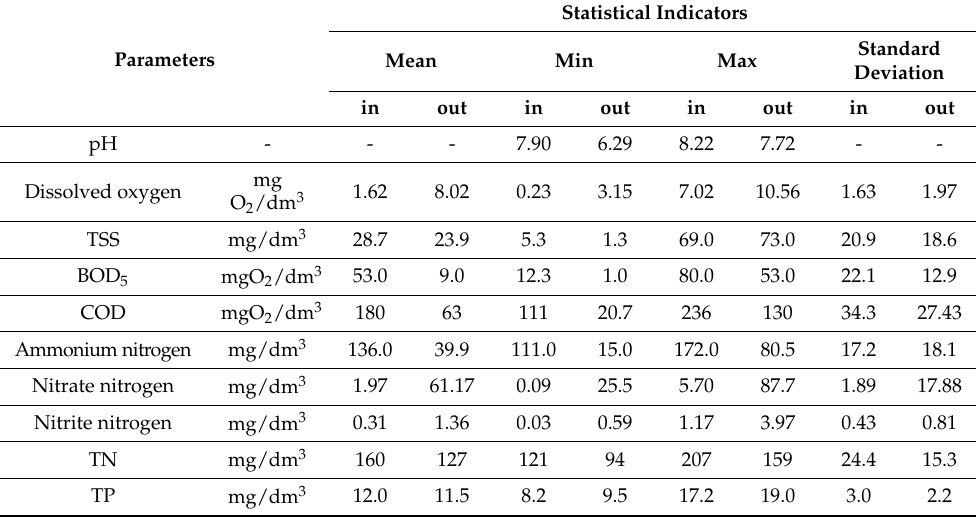
Table 2. Pollutant concentrations in the inflow and outflow of facility no. 1. TSS, total suspended solids; BOD 5 , biochemical oxygen demand in 5 days; COD, chemical oxygen demand; TN, total nitrogen; TP, total